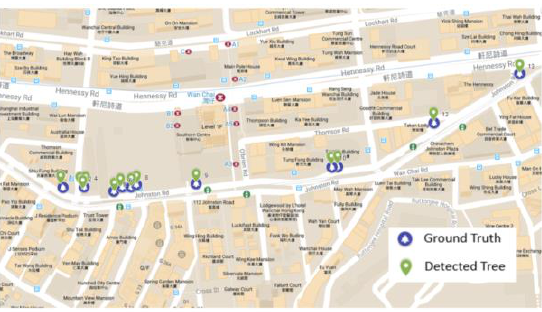
Figure 18. Result for Johnston Road in map view. Figure 17 and Figure 18 display the result in map for Hospital Road and Johnston Road respectively. The offset value for field of view is set to 440px, epsilon for spatial clustering is 4 meters and mean planimetric deviation is within 3 meters.